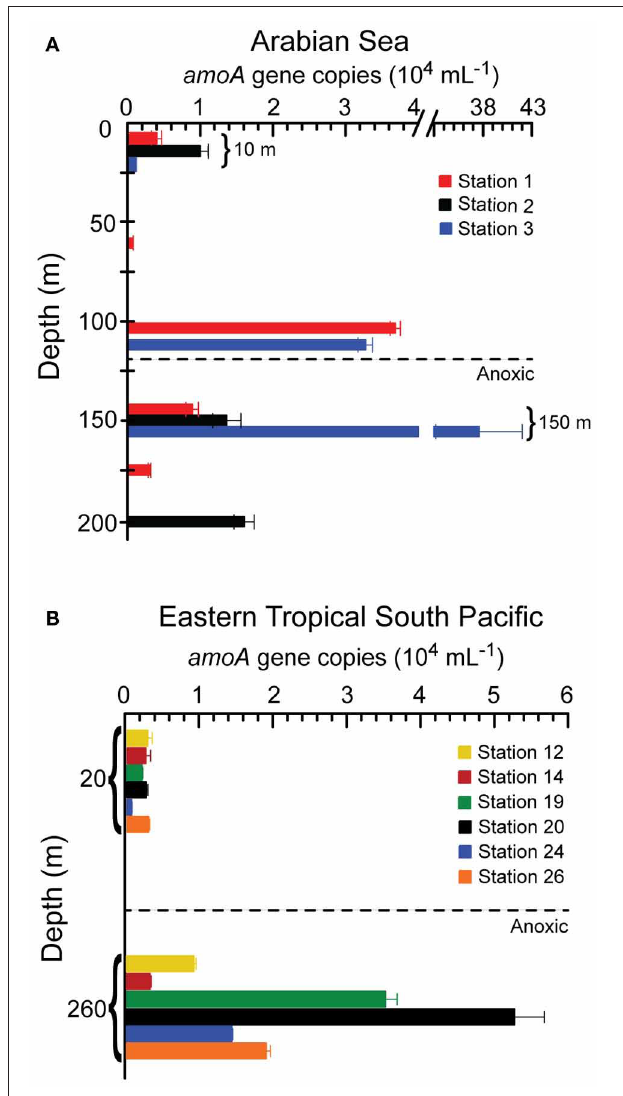
FIGURE 2 | Archaeal amoA abundance in copies mL − 1 at different depths in the Arabian Sea (A) and the Eastern Tropical South Pacific (B). Error bars represent standard deviations of the triplicates in the QPCR run. In some cases the error bars were shorter than the width of the symbol and hence not visible. Different depths were sampled at different stations, so missing bars do not imply zero abundance, rather that samples were not analyzed at those depths.